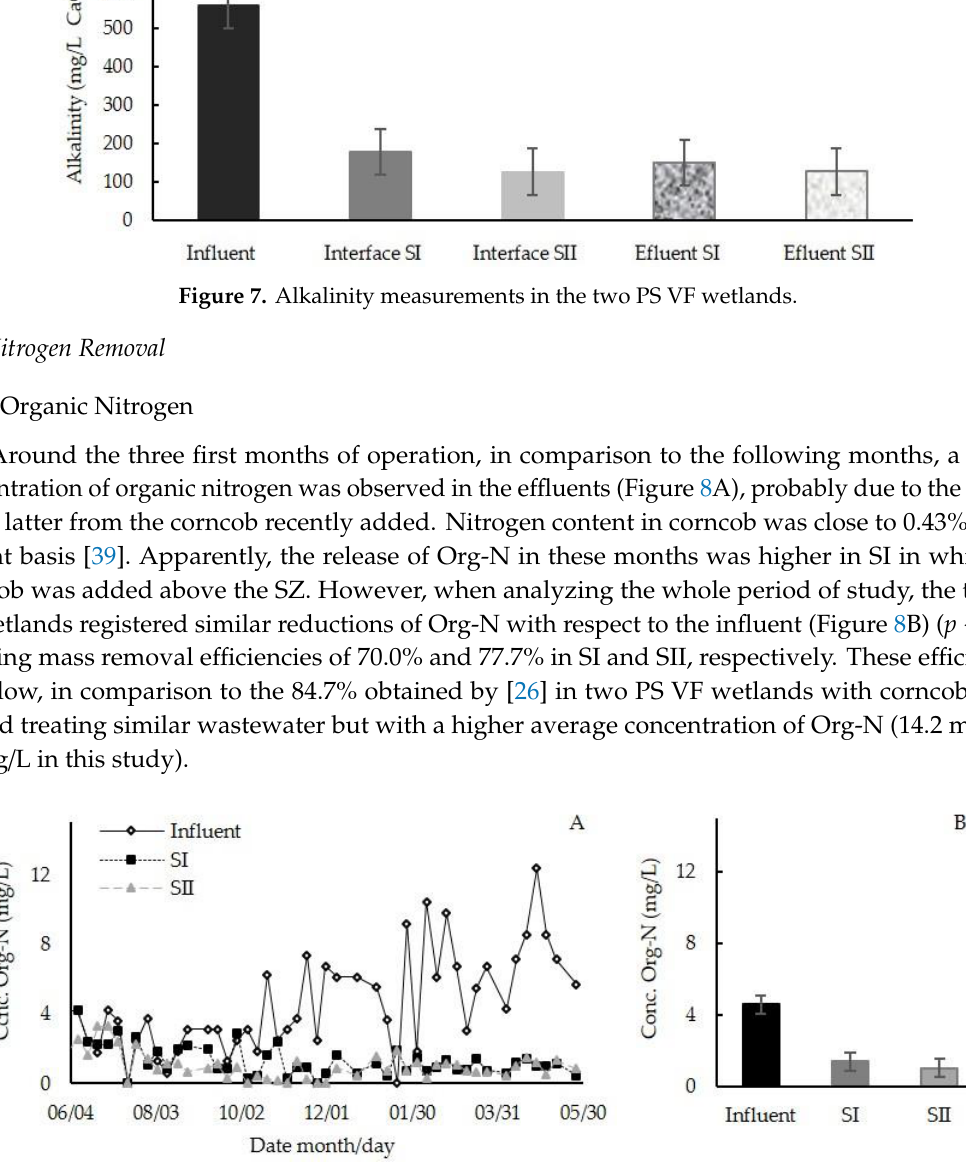
Figure 8. Organic nitrogen concentrations in the study with PS VF wetlands, ( A ) values along the sampling campaigns, ( B ) mean concentrations (± standard error) throughout the period of study.